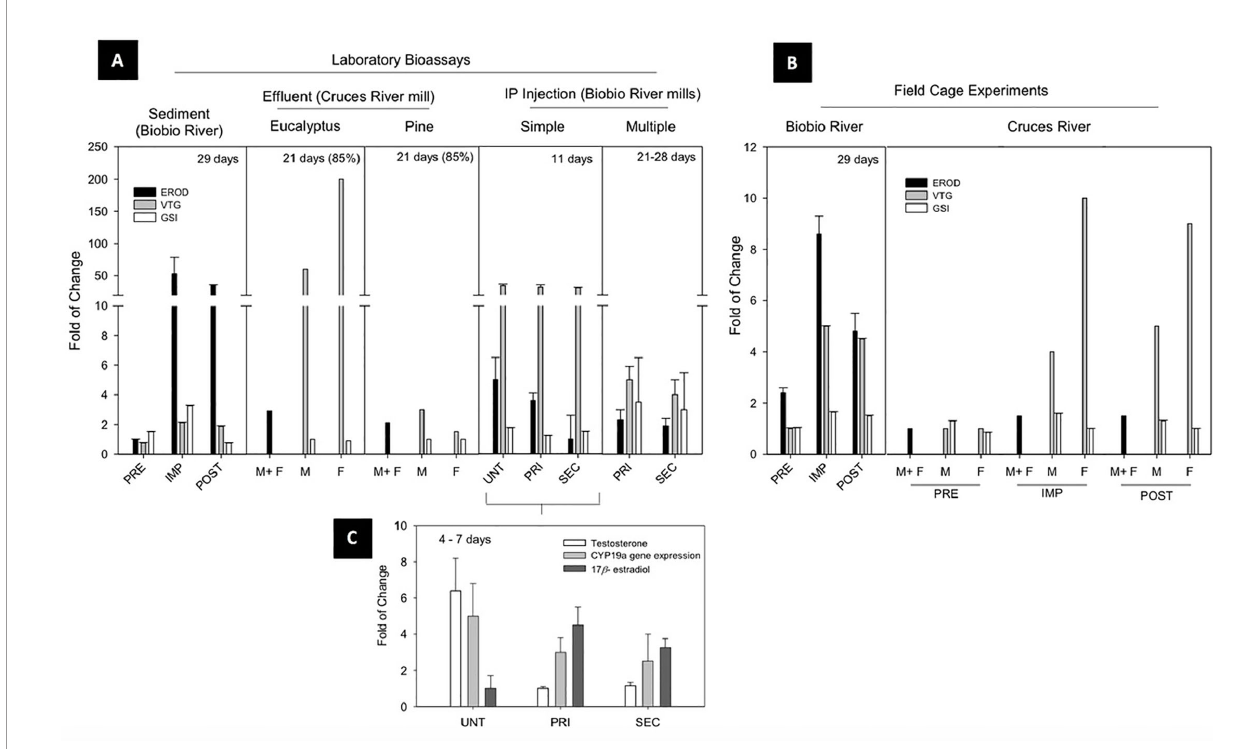
FIGURE 3 | Reproductive endocrine disruption endpoints in non-native fi sh: Pulp and paper mill ef fl uents evidence. (A) Laboratory Bioassays, (B) Field Cage Experiments and (C) Effect of mill extractives IP injection over steroids levels and cyp 19a gene expression. PRE, preimpact zone; IMP, impact zone; POST, postimpact zone; M, male; F, female; UNT, untreated ef fl uent; PRI, primary treated ef fl uent; SEC, secondary treated ef fl uent; IP, intraperitoneal; EROD, ethoxyresoru fi n-O-deethylase; VTG, vitellogenin; GSI, gonadosomatic